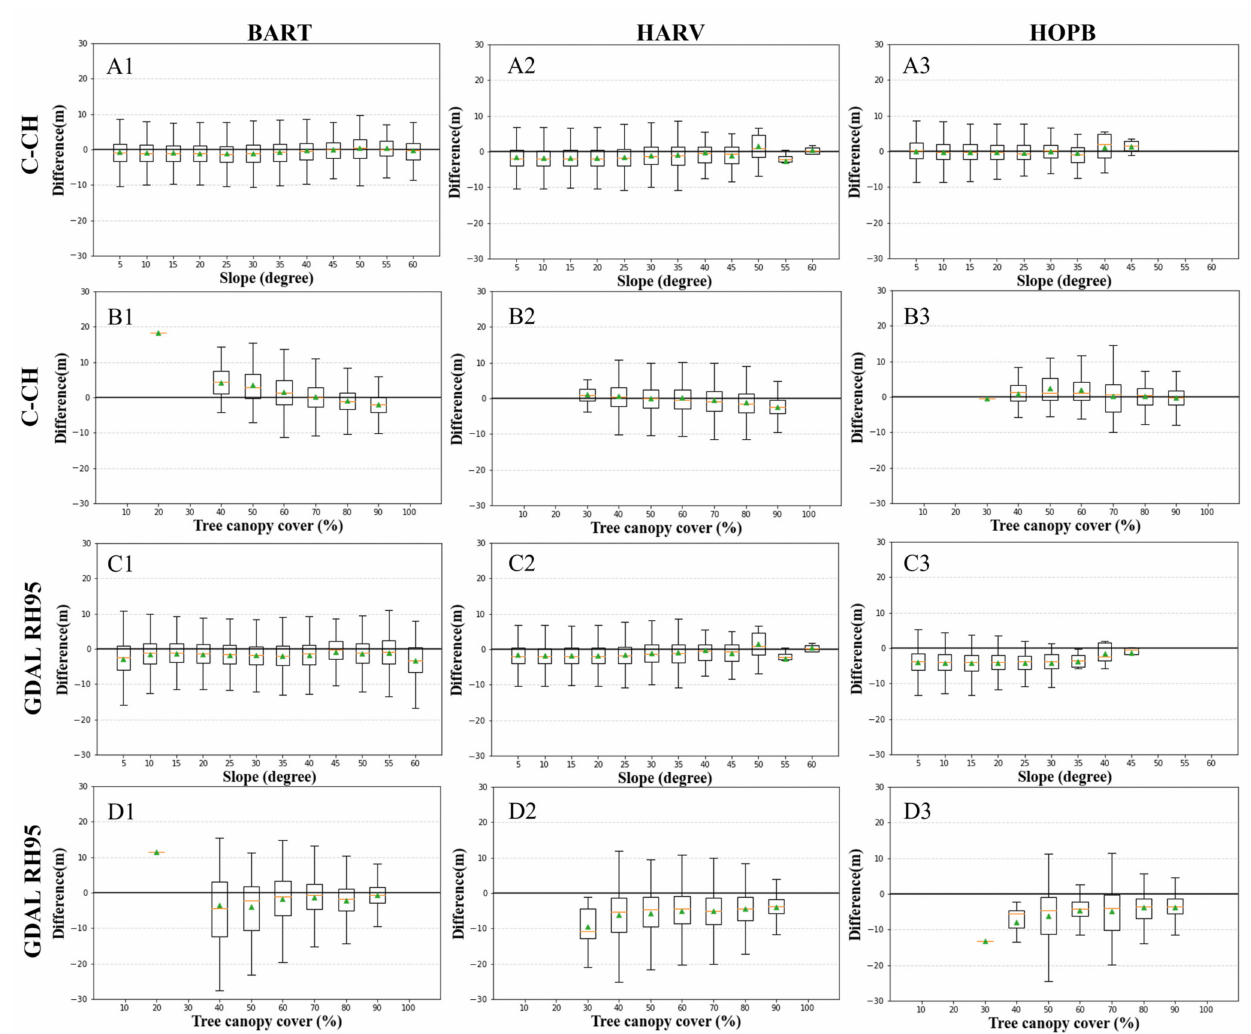
Figure 7. Canopy height residuals of C-CH ( A , B ) and GDAL RH95 ( C , D ) plotted as a function of slope ( A1 – A3 , C1 – C3 ) and tree canopy cover ( B1 – B3 , D1 – D3 ) in BART, HARV, and HOPB. To be readable, the median and average of residuals are shown by the orange line and a green triangle in the box, respectively. The negative median and average values indicate under-and over-estimation, respectively. The upper and lower quartiles are indicated by the end of the